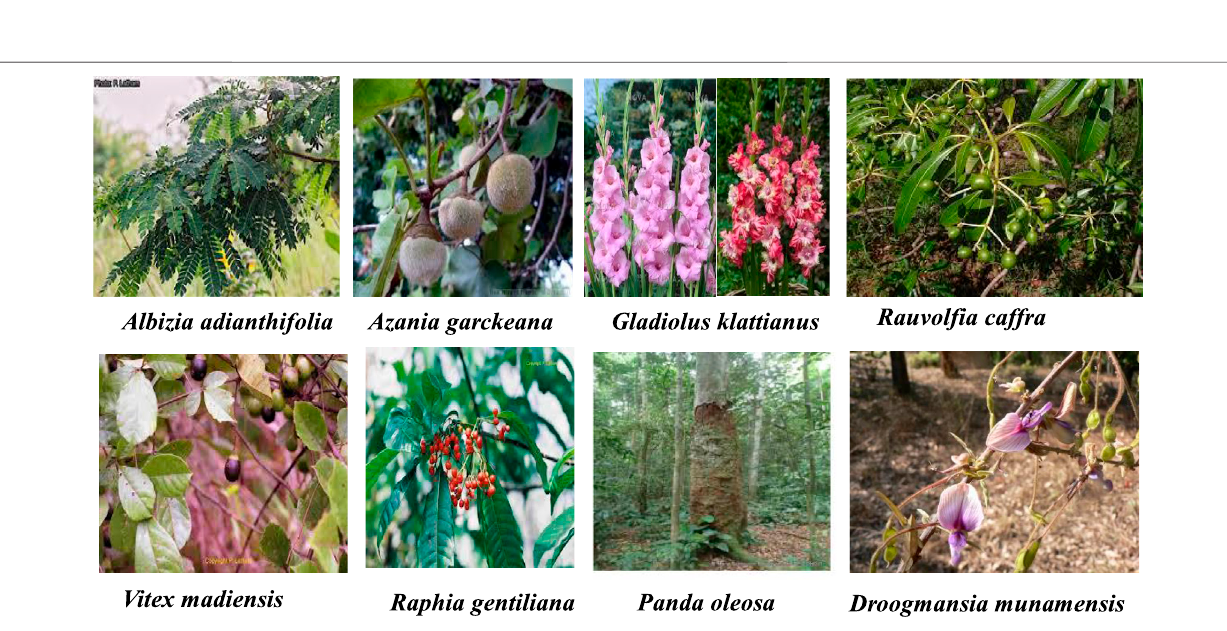
Frontiers in Pharmacology |